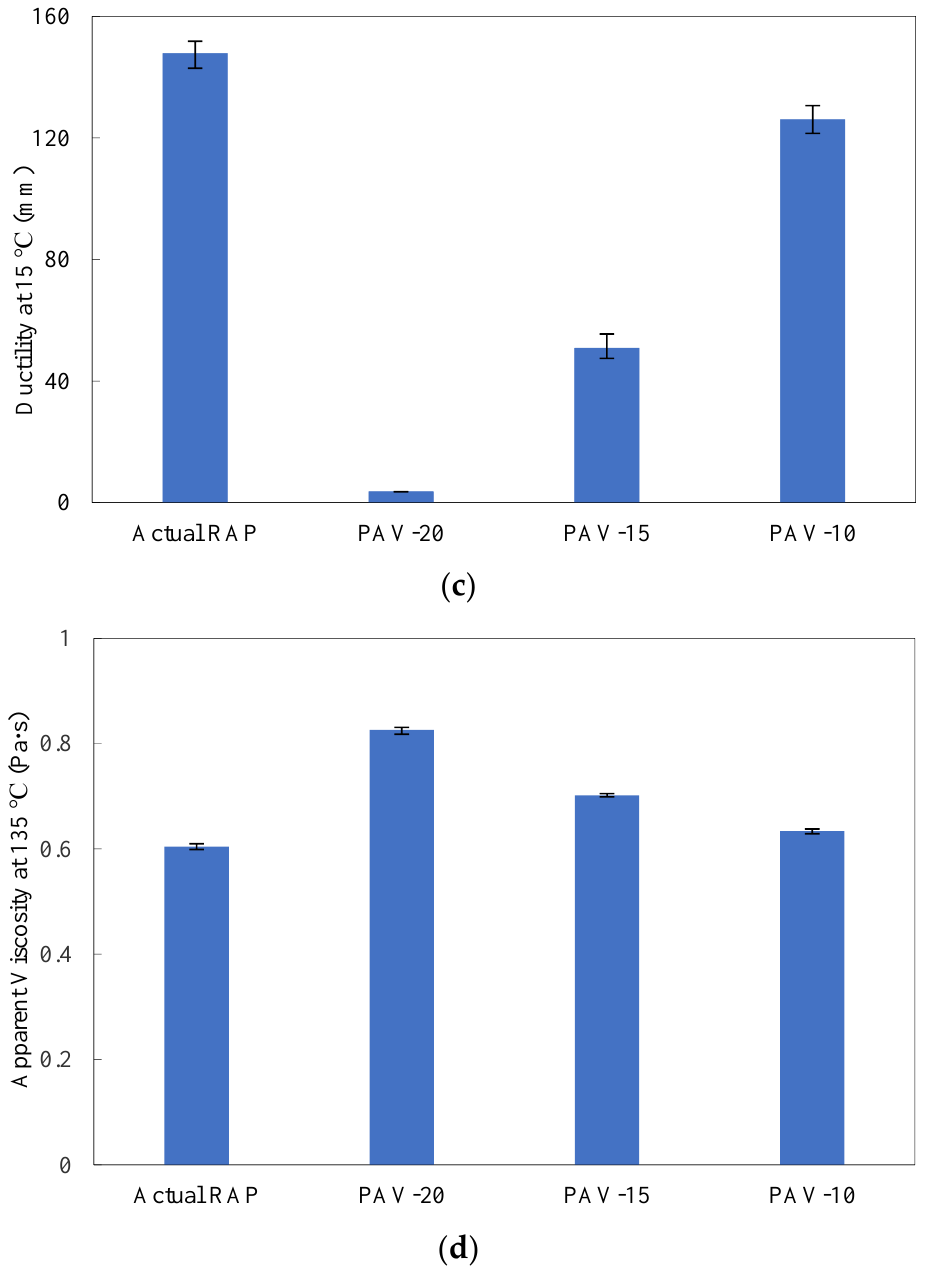
Figure 3. Basic properties of artificial RAP binders aged at different PAV exposure times: ( a ) penetration; ( b ) softening point; ( c ) ductility; ( d ) apparent viscosity.